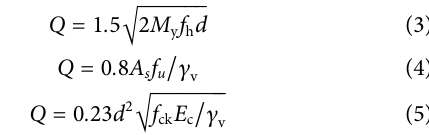
Frontiers in Materials |